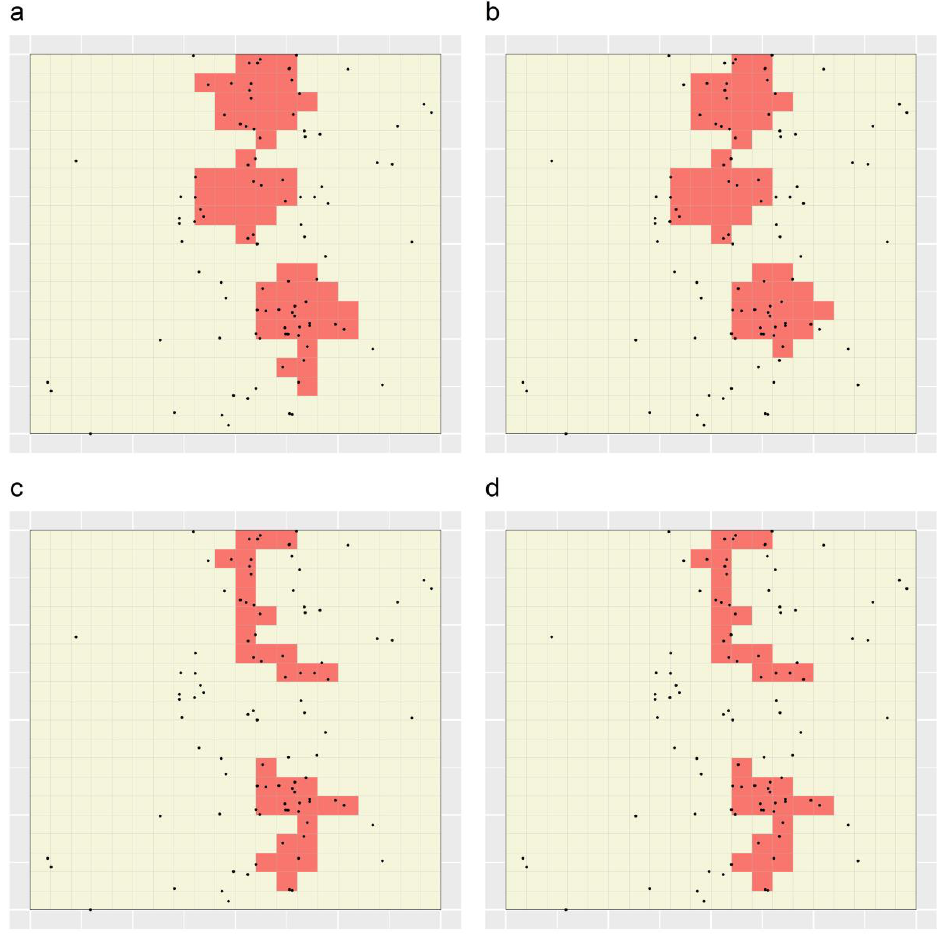
Figure 8. Sets of TRs delineated through applying the distance- and value-weighted STAs to a simulated dataset, either ( a , c ) with splitting, or ( b , d ) without splitting. Black dots depict the locations of simulated cases, and grid lines represent the set of minimal units. In each panel, shaded regions comprise ≥ 50% of